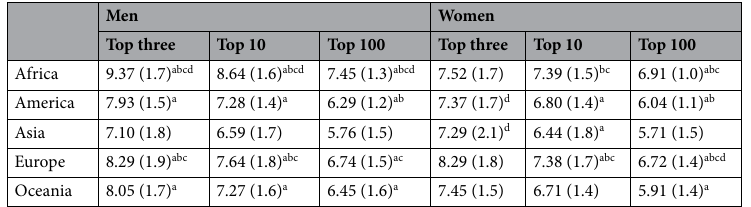
Table 1. Descriptive results (mean ± SD for miles/h) for performance (speed mean, mile/h) according to gender and performance level. SD standard deviation. a difference for Asia; b difference for America; c difference for Oceania; d difference for